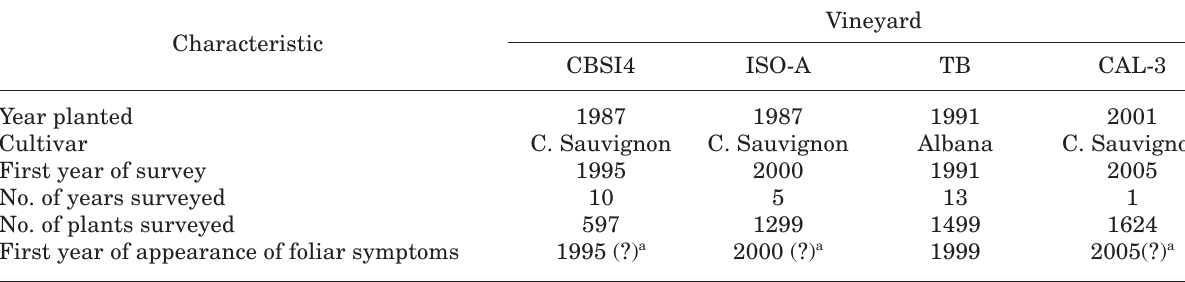
Table 1. Characteristics of the four vineyards surveyed for esca in the present study.